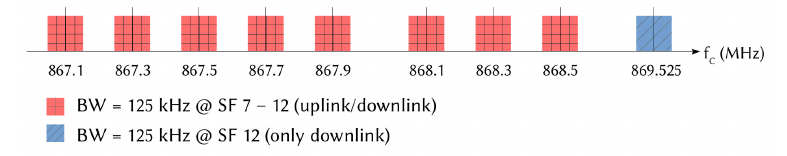
Figure 3. Example of LoRa channels used in